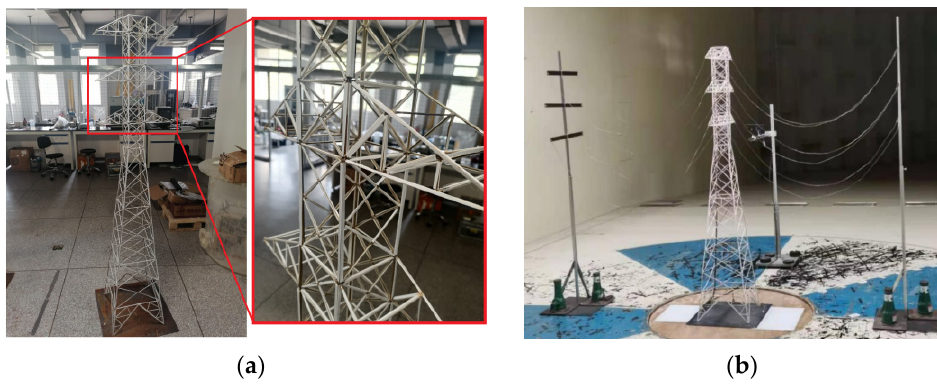
Figure 13. The tower-line coupled scale model. ( a ) Single tower; ( b ) Tower and lines.